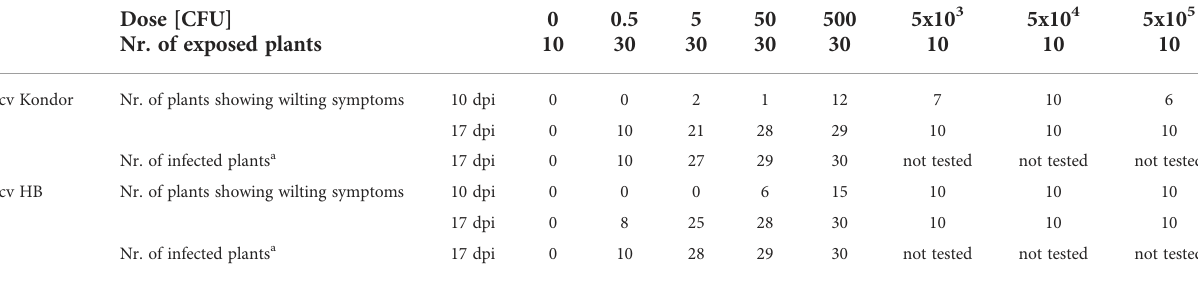
TABLE 4 Symptomatic (wilting) and non-symptomatic infections after stem-inoculation of in vitro potato plants of two cultivars Kondor and HB with different doses of Ralstonia solanacearum .